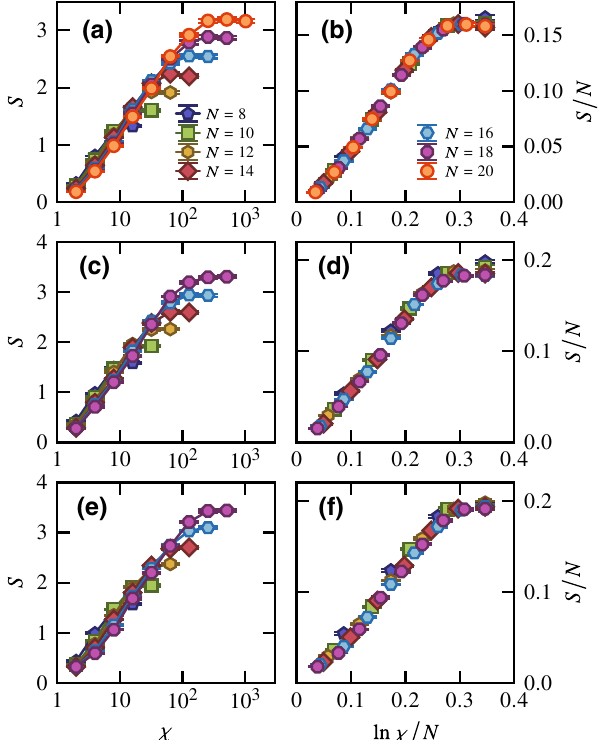
FIG. 8. Top row: 3-regular graphs with unit weight and QAOA depth p = 1. Middle row: 3-regular graphs with unit weight and QAOA depth p = 2. Bottom row: complete graphs with uniform random weight w ij ∈ [0, 1] and QAOA depth p = 4. Left col- umn: the probability p min of finding a bit string minimizing the cost function of the Max-Cut problem versus the bond dimension χ for various system sizes N . Right column: the same data as the left column, except that the x axis is rescaled by exp ( − N /(cid:11)) and the y axis by exp ( N /(cid:12)) , where (cid:11) and (cid:12) are two parameters such that the data collapse. We find (cid:11) ≈ 5 in the three cases and (cid:12) ≈ 3.3, 4.3, and 3.8 in (b), (d), and (f),